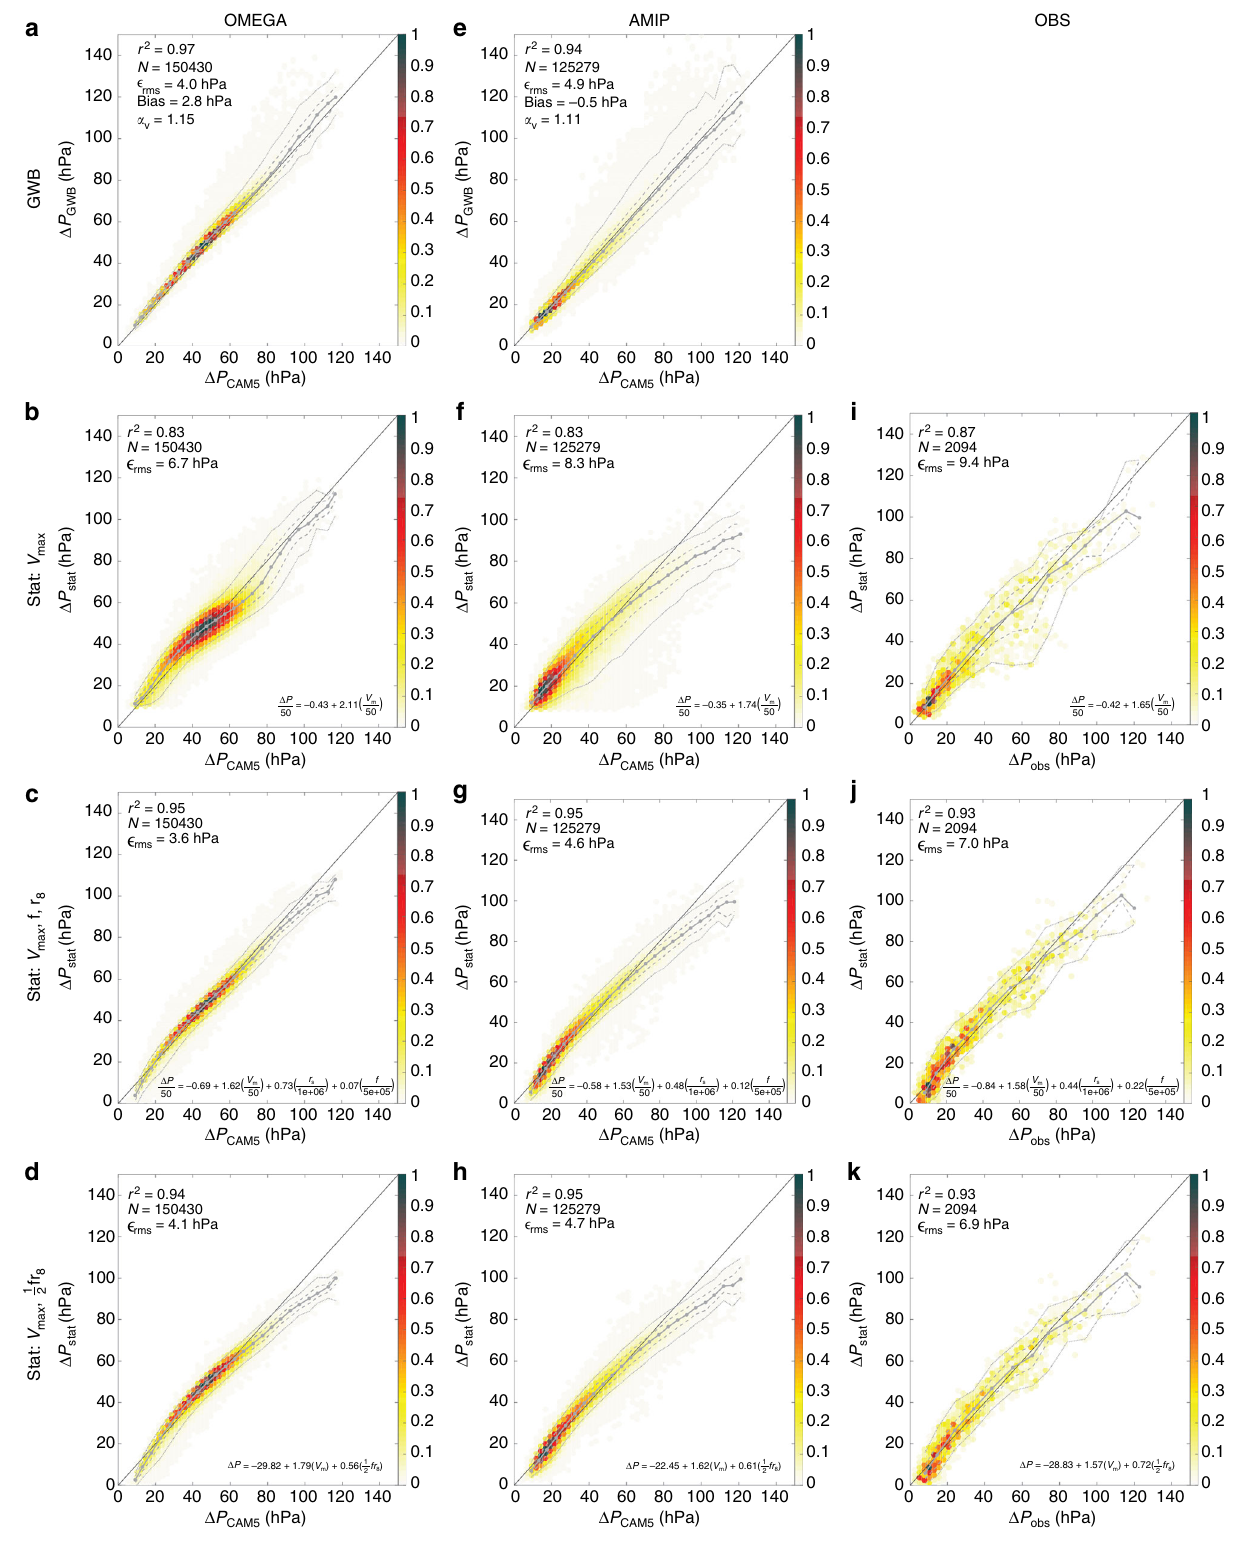
Fig. 4 Predicted vs. actual Δ P (hPa) across simulations and observations. a Direct gradient wind balance model for OMEGA. b MLR model with predictor V V f , r m for OMEGA c MLR model with three predictors ( m , 8 ) for OMEGA. d MLR model with two predictors ( AMIP. i – k Same as b − d for observations. Color denotes relative frequency within hexagonal bin. Black line denotes one-to-one correspondence. Gray lines denote median (solid), interquartile range (dashed), and 5 – 95% range (dotted) of predicted Δ P within 5 hPa bins of Δ P CAM5 and Δ P obs starting from zero, plotted at bin-median value of each (dot) for bins with at least fi ve data points. N denotes sample size. For GWB, mean prediction bias de fi ned as Δ P (cid:1) Δ P α V denotes wind speed rescaling GWB CAM5 , and